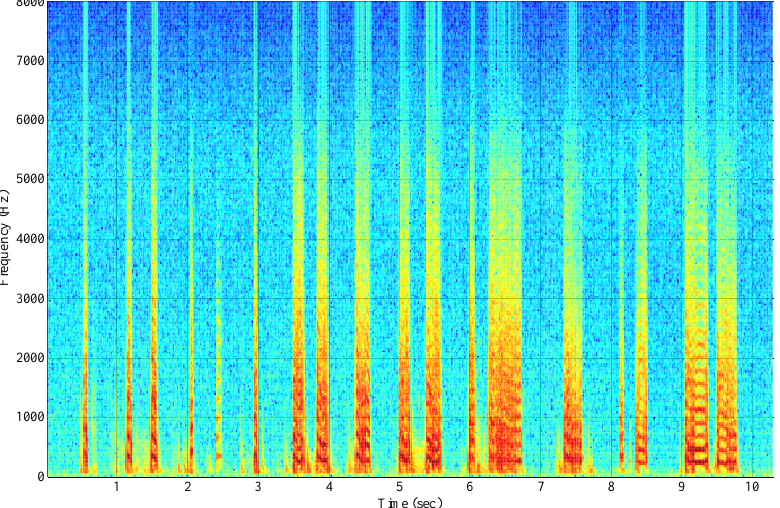
Figure 10. Spectrogram of a recording of common housefly, Musca domestica from the optoelectronic sensor. All specimens were manually held in and out of the beam while flapping their